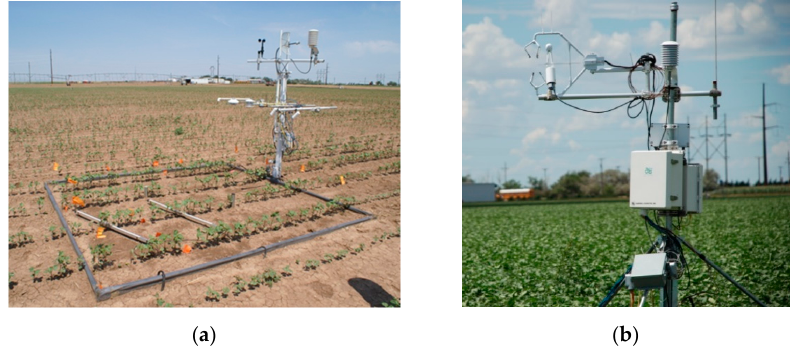
Figure 1. ( a ) Lysimeter box with micrometeorological instrumentation and ( b ) eddy covariance system. Photographs courtesy of Dr. José Luis Chávez.